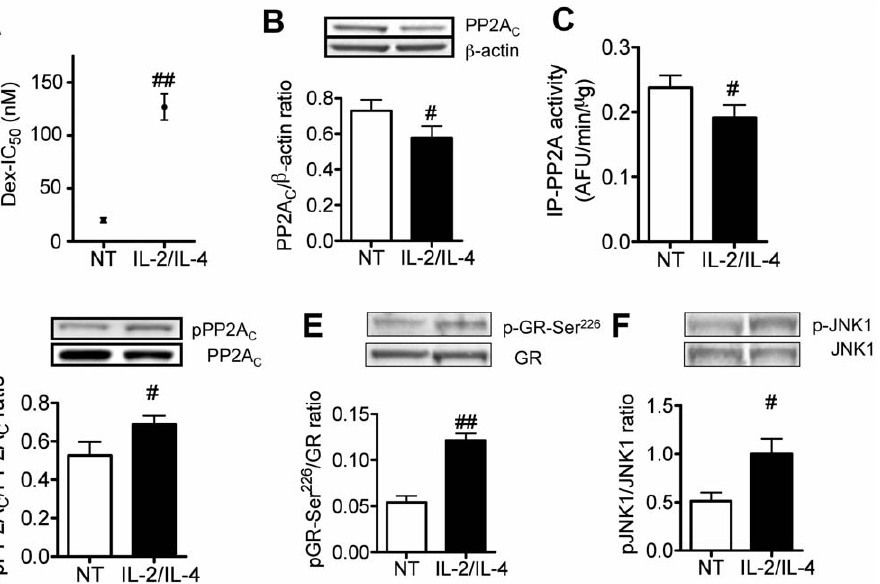
Figure 2. PP2A function in IL-2/IL-4-treated U937 cells. Effects of IL-2/IL-4 co-treatment for 48 h on IC 50 of dexamethasone on TNF a -induced IL-8 release (A), PP2A C protein expression (B), immunoprecipitated PP2A (IP-P2A) activity (C), PP2A C -Tyr 307 phosphorylation(D), GR-Ser 226 phosphorylation (E) and JNK1 phosphorylation (F). Values represent means 6 SEM (n=3–4). # P , 0.05, ## P , 0.01 (vs. non-treatment control; NT).